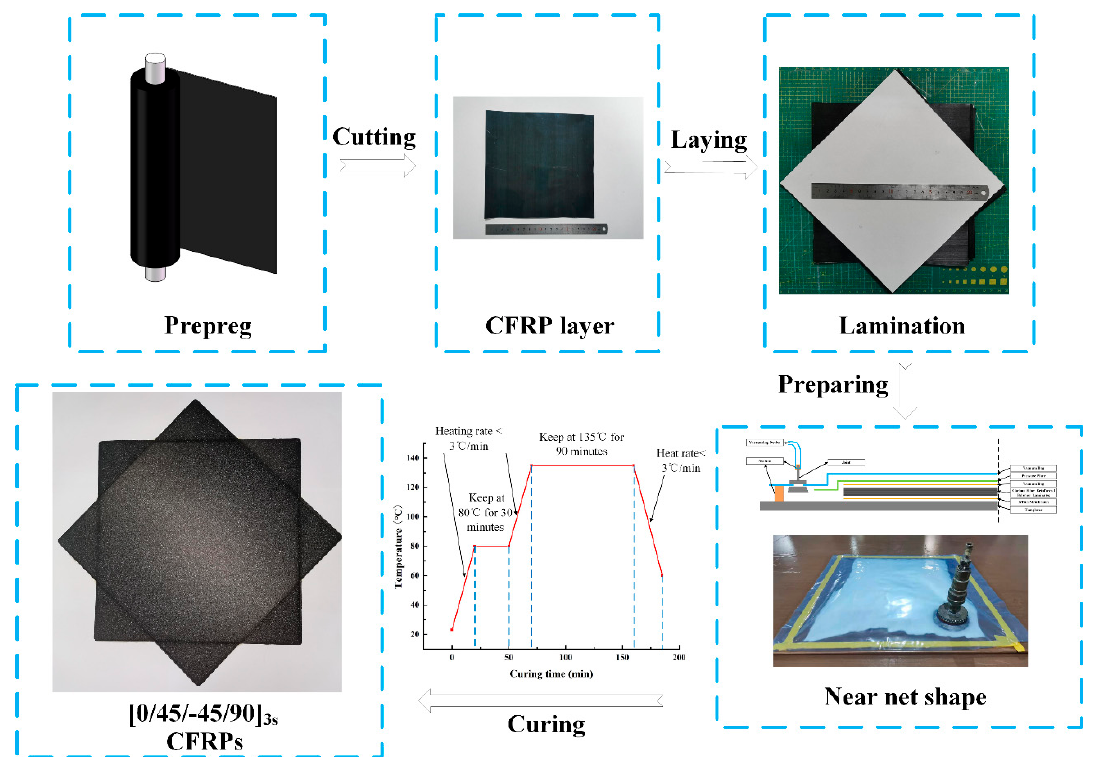
Figure 1. Schematic illustration of the manufacturing process of a carbon fiber-reinforced plastic (CFRP) plate.